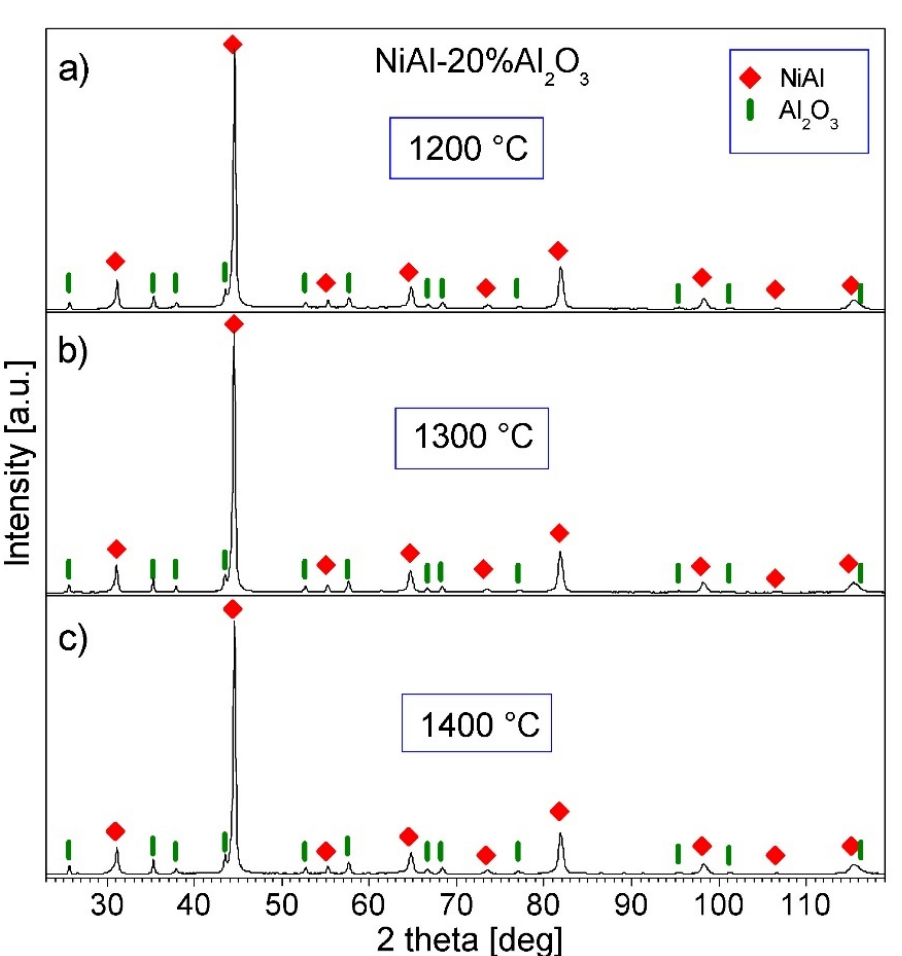
Figure 10. XRD patterns of the NiAl-20%Al2O3 samples consolidated by PPS: ( a ) at 1200 °C; ( b ) at 1300 °C; ( c ) at 1400 °C.